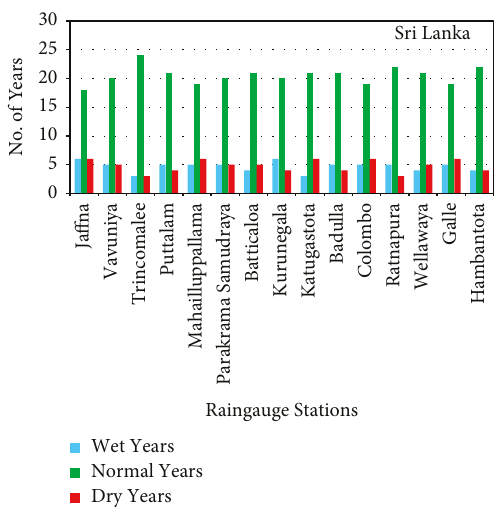
Figure 4: Plot of station-wise distribution of wet, normal, and dry years.